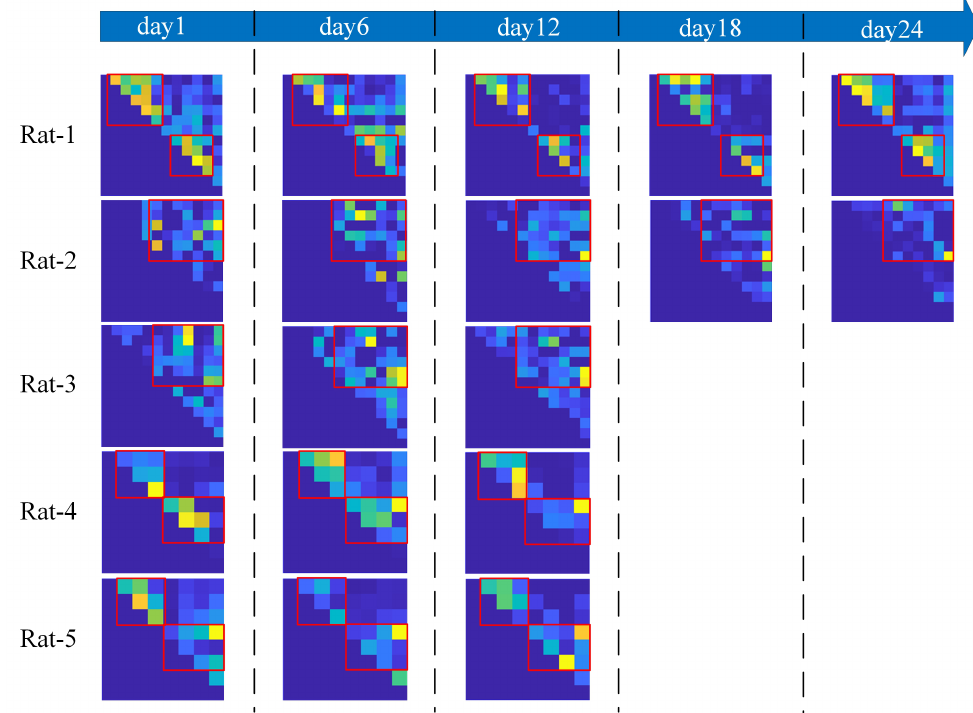
Figure 5. QCCS matrix changes of all rats every 6 days. The red box indicates the area with enhanced synchronization.